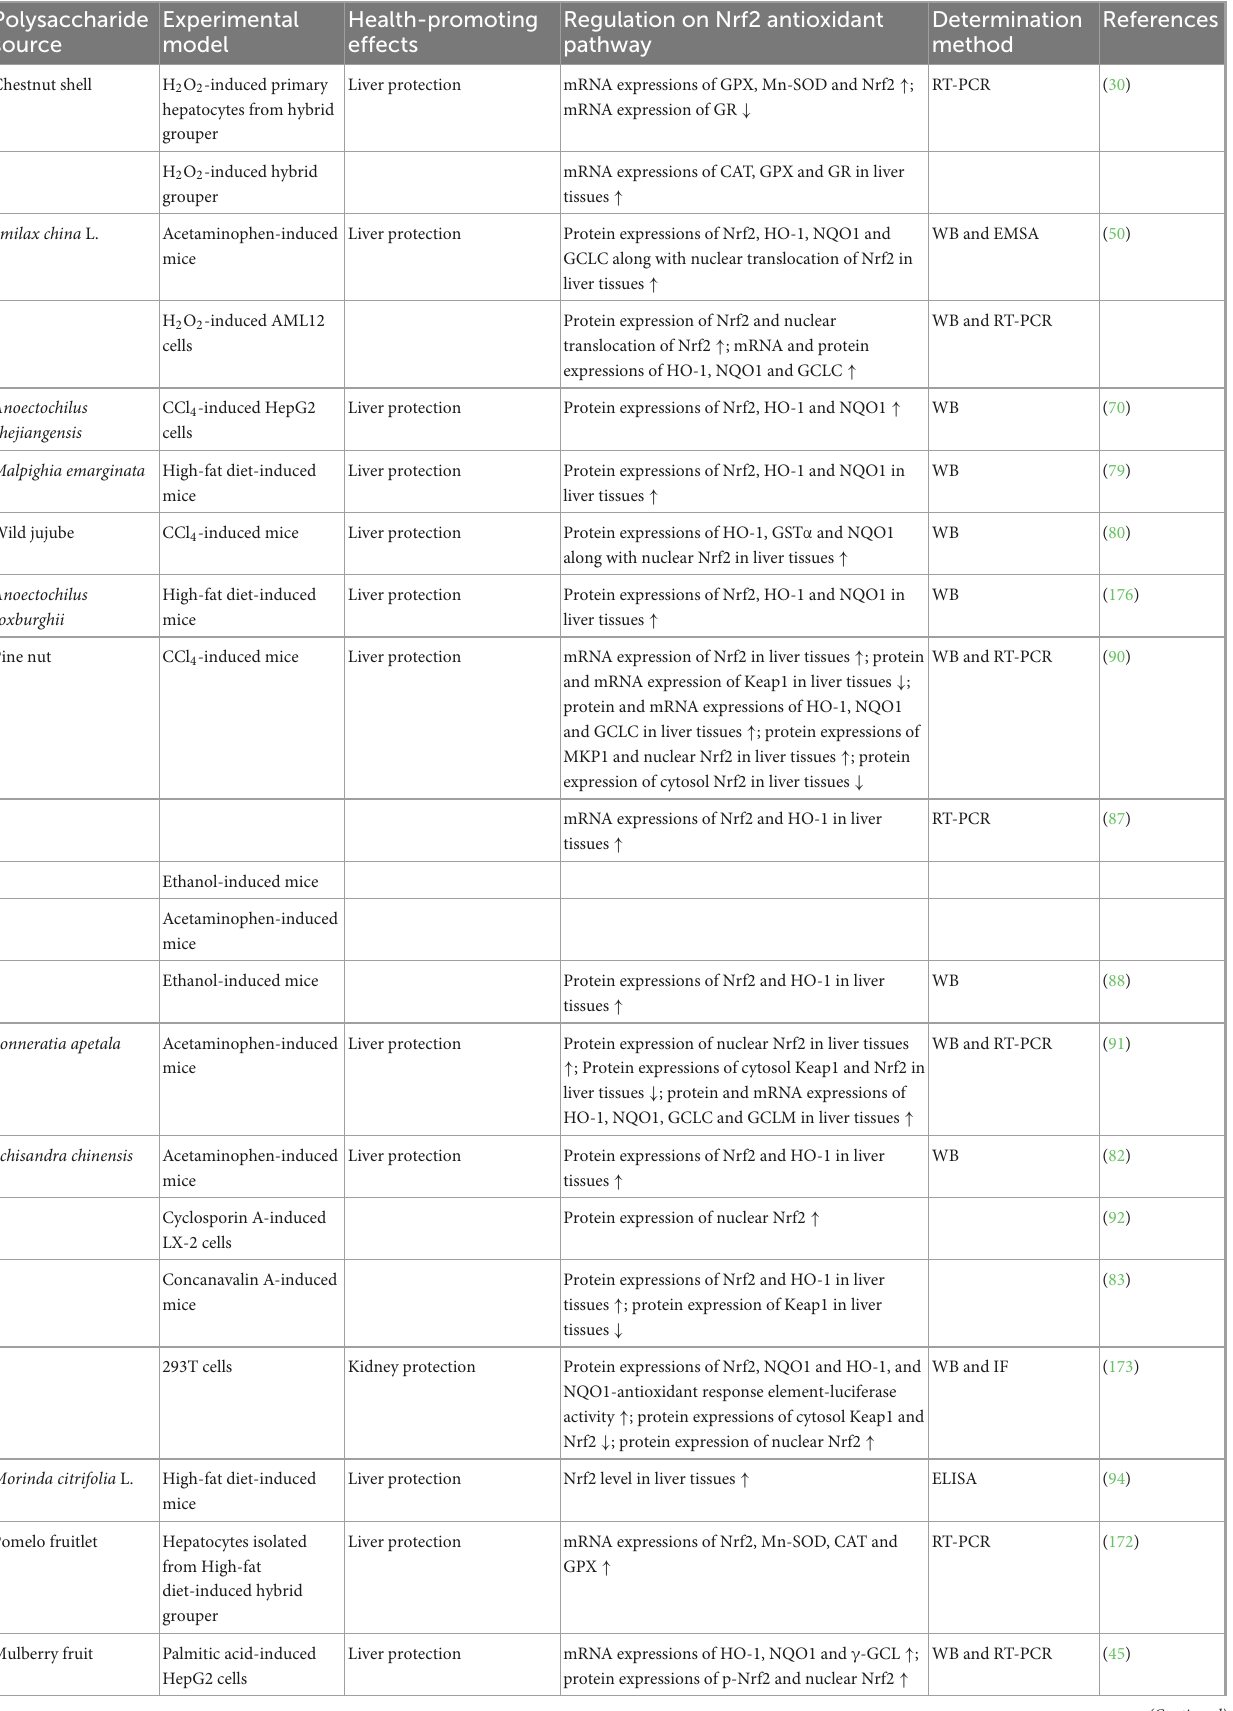
TABLE 2 Regulation of NPs from woody plants on Nrf2 antioxidant pathway for health-promoting